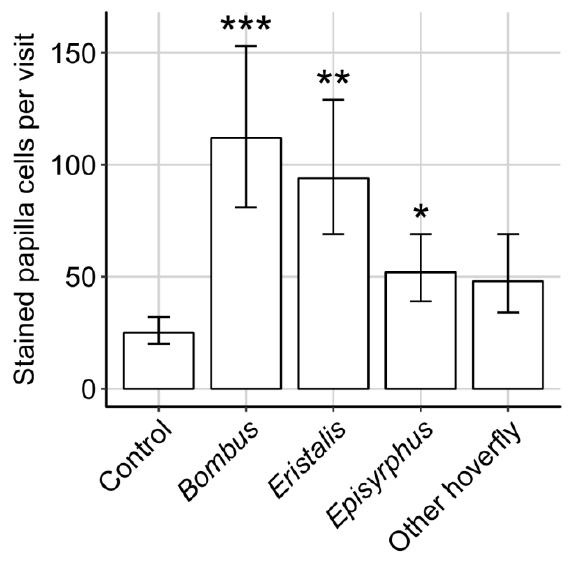
F IGURE 5. Results of papilla cell response to single insect visits, showing that insect visitors transfer self-pollen onto the stigma during a visit. Asterisks show significance in comparison to the control: ‘***’ = P < 0.001; ‘**’ = P < 0.01; ‘*’ = P < 0.05. Estimates (mean ± 1 SE) are produced from final model (see Tab. 1 for statistics and sample